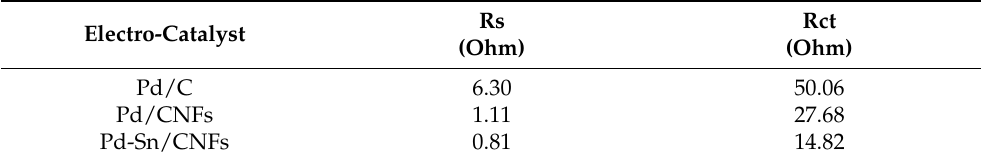
Table 7. EIS resistance values for electro-catalysts in ethanol oxidation.